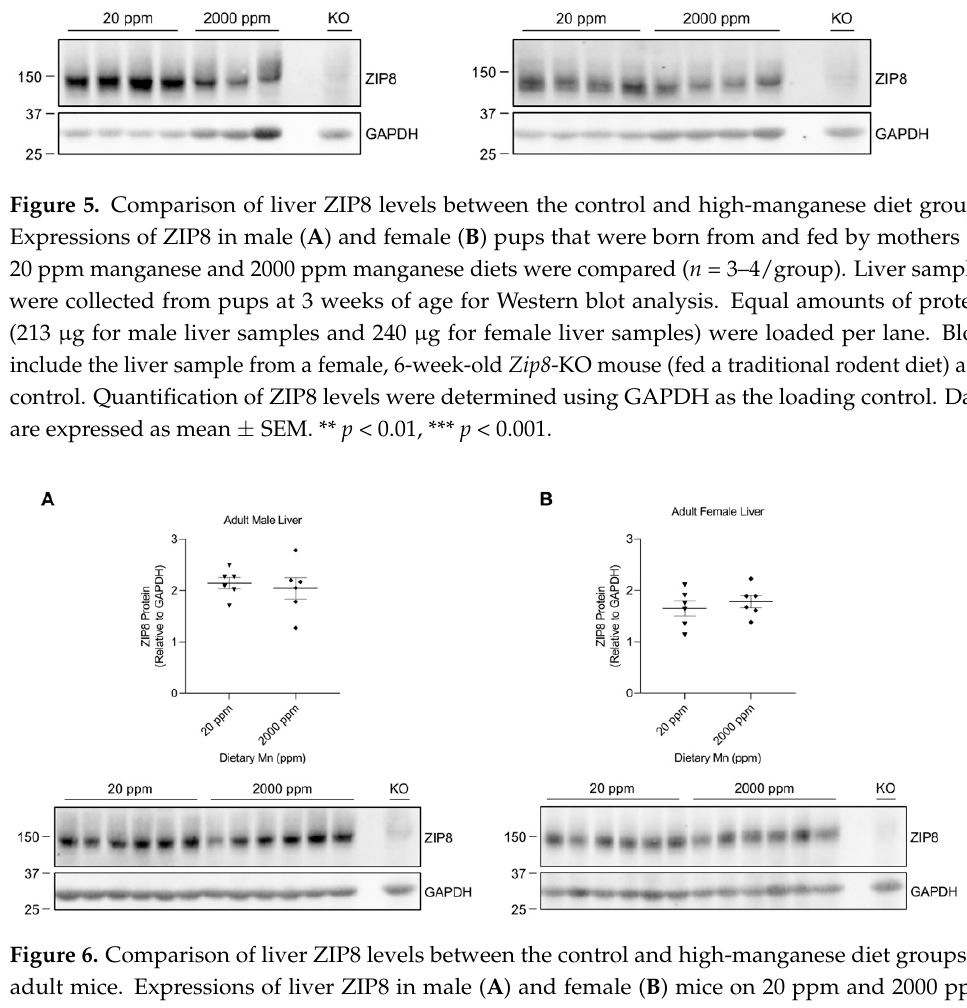
Figure 6. Comparison of liver ZIP8 levels between the control and high-manganese diet groups in adult mice. Expressions of liver ZIP8 in male ( A ) and female ( B ) mice on 20 ppm and 2000 ppm manganese diets were analyzed by Western blotting ( n = 6/group). Liver samples were collected at 12 weeks of age. Equal amounts of protein (222 µg for male liver samples and 220 µg for female liver samples) were assessed. Blots include the liver sample from a female, 6-week-old Zip8 -KO mouse (fed a traditional rodent diet) as a control. Quanti fi cation of ZIP8 levels were determined using GAPDH as the loading control. Data are expressed as mean ± SEM.